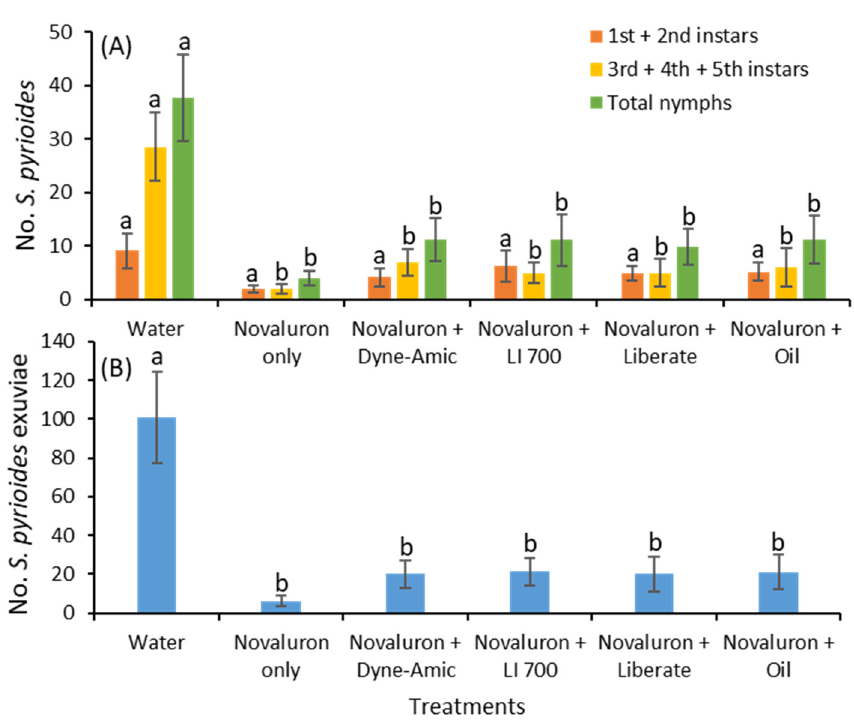
Figure 4. Mean ( ± SE) ( A ) numbers of various instars of S. pyrioides and ( B ) exuviae when adults that ingested novaluron and novaluron + various adjuvants were allowed to oviposit for 7 d on insecticide-free plants. Bars with the same fill color with the same letters are not significantly di ff erent (Tukey’s HSD test, p = 0.05).